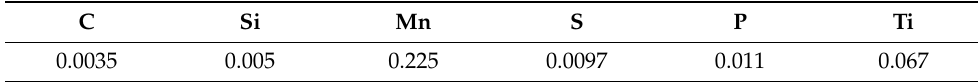
Table 1. Chemical composition of interstitial free (IF) steel (wt%).